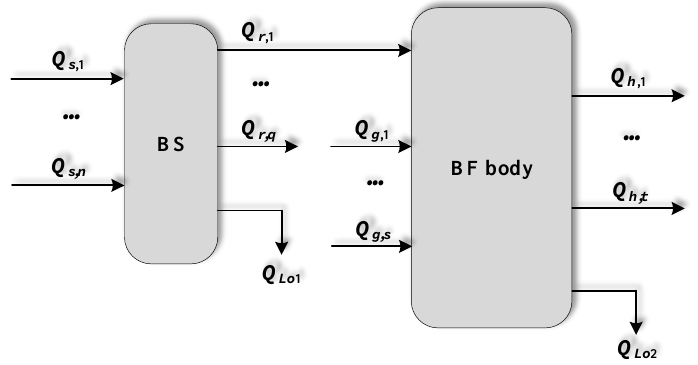
Figure 3. Energy flows analysis model.